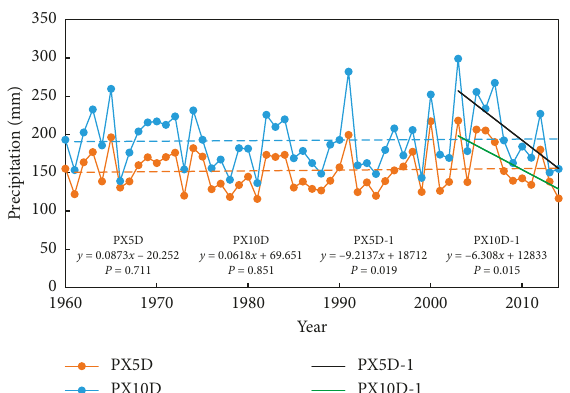
Figure 3: Changes of extreme precipitation indices of PX5D and PX10D in the HRB. Dashed lines indicate the linear trend of PX5D and PX10D, and black and green lines indicate the trends of PX5D and PX10D during the period between 2003 and 2014.